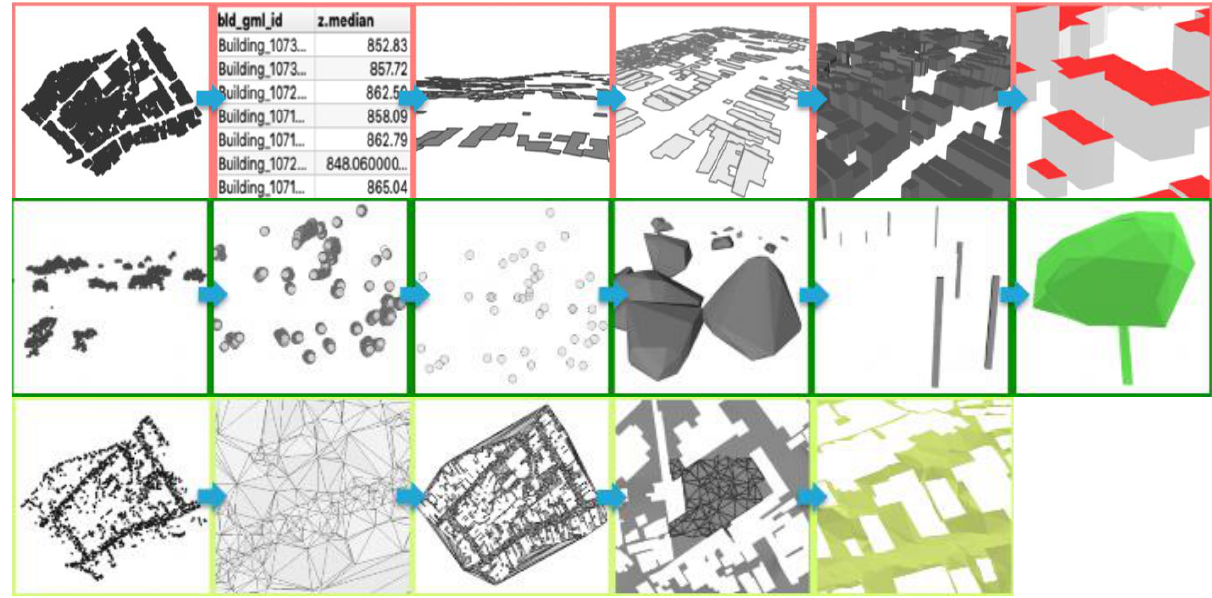
Figure 3. Visual overview of the 3D modelling workflow for buildings [top], trees [centre] and relief [bottom]. national standard CityGML. For the 3D urban scene, only 3 features classes were considered: buildings, vegetation (trees) and relief. The 3D modelling was carried out integrating FME and Python. The datasets used were again the Lidar point cloud and the 2D buildings dataset containing the building footprints.